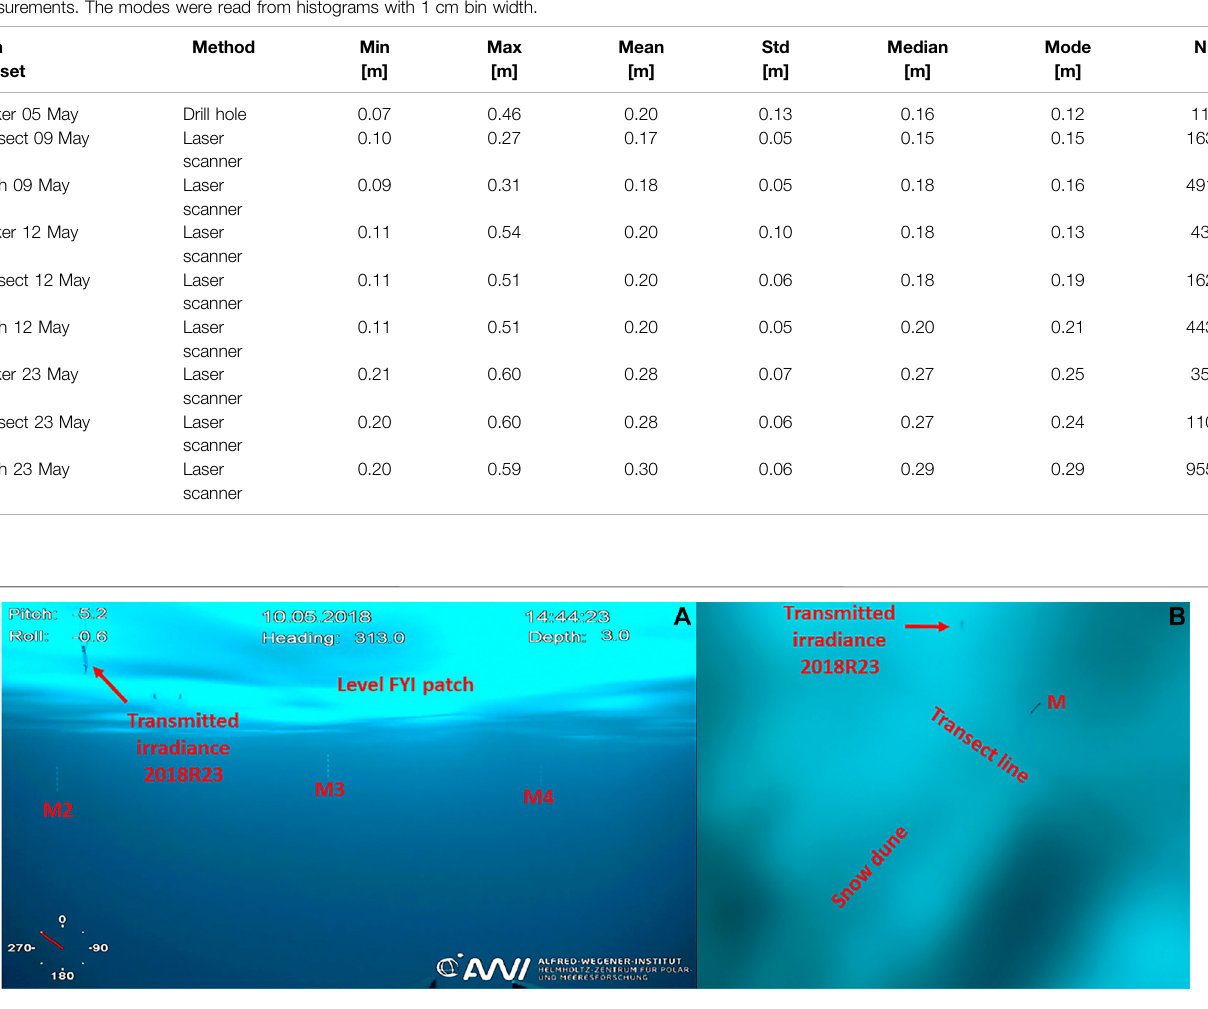
FIGURE 2 | (A) Underwater image of the level FYI patch on 10 May as extracted from a video taken by the ROV HD camera. (B) Underwater upward looking still image at 55.6 m depth as taken by a 14.1-megapixel Tiger Shark camera (Imenco, Norway) attached to the ROV on 12 May.